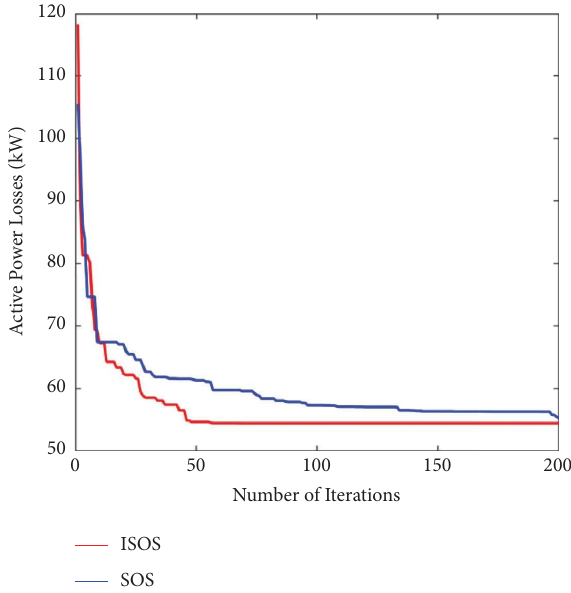
Figure 4: ISOS and SOS convergence characteristics for 33-node